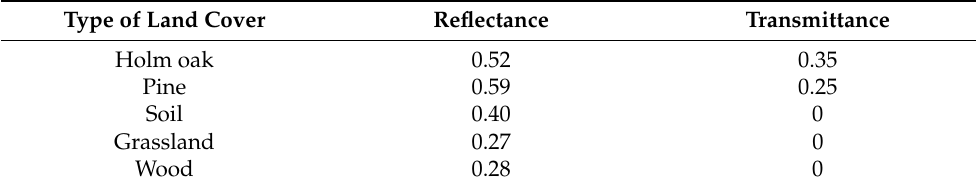
Table 3. Reflectance and transmittance values assigned to the major land cover types present in the